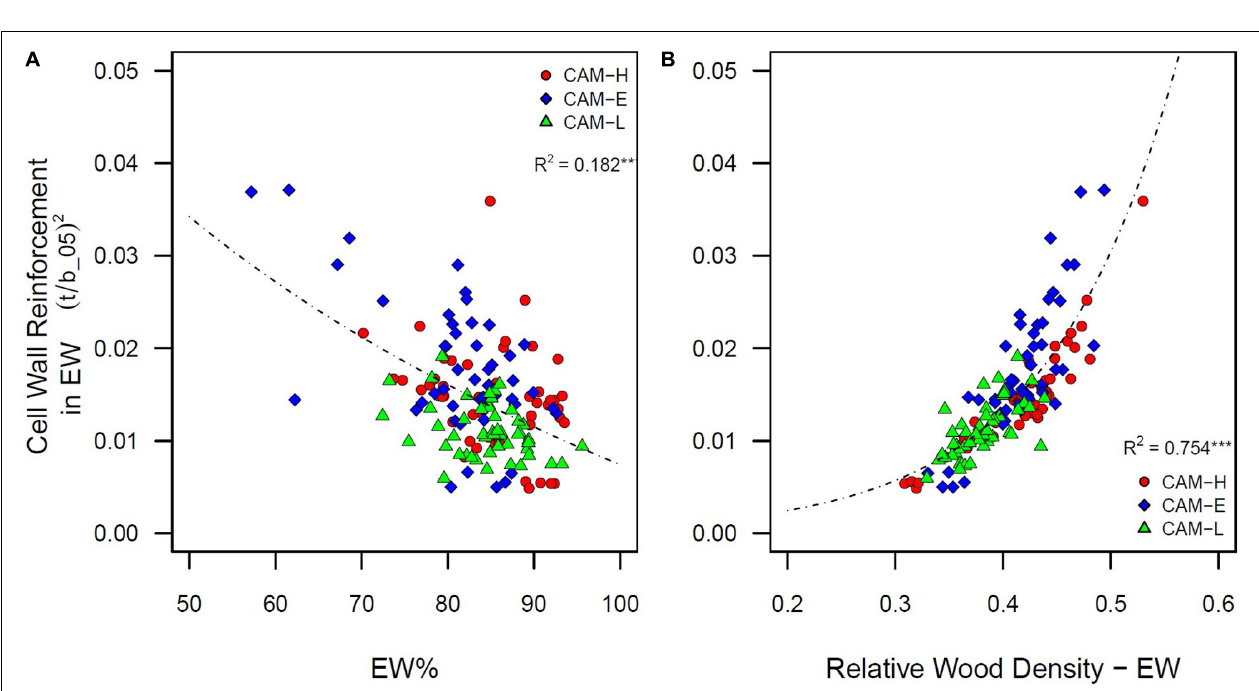
FIGURE 5 | (A) Cell wall reinforcement index ([t/b _05 ] 2 ) in EW portion (5th percentile) as a function of earlywood percentage (EW%). A logarithmic function was fitted. (B) Cell wall reinforcement index ([t/b] 2 ) in EW portion (5th percentile) as a function of relative wood density in the earlywood. Each symbol (circle, diamond, and triangle) corresponds to a tree from the three plots CAM-H (red), CAM-E (blue), and CAM-L (green). An exponential function was fitted. All relationships are significant (*** P < 0.001).